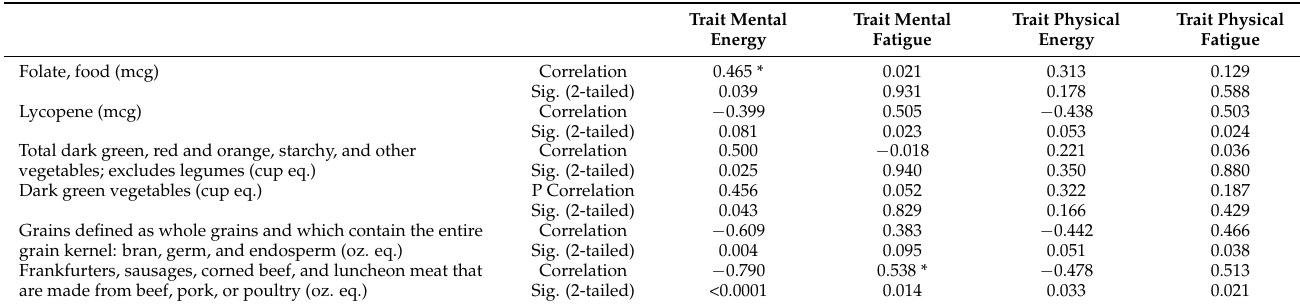
Table 3. Correlation of traits with nutrients and food groups from 24 h recall.